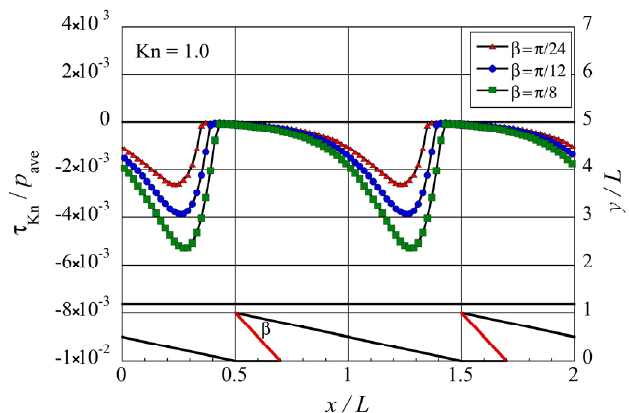
Figure 9. Distributions of the local tangential Knudsen stress due to molecules coming from the modified side of the modified ratchet microstructure, for different tip angles β at Kn = 1.